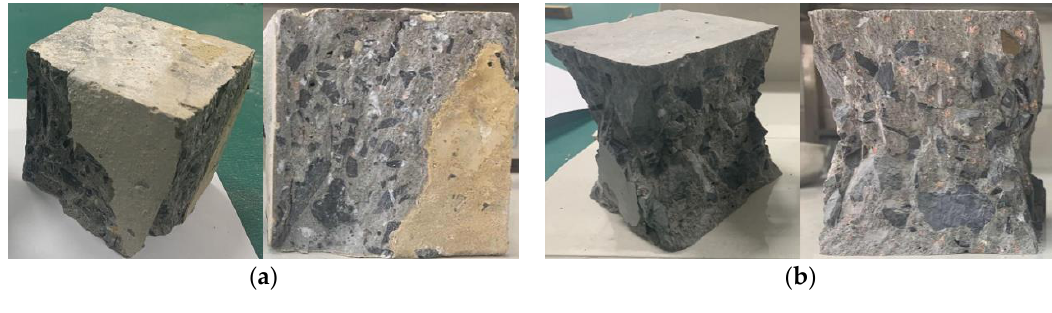
Figure 6. Appearance of 70–180,000 ppm concrete at 90 and 180 days. ( a ) 70–180,000 ppm; ( b ) other specimens.